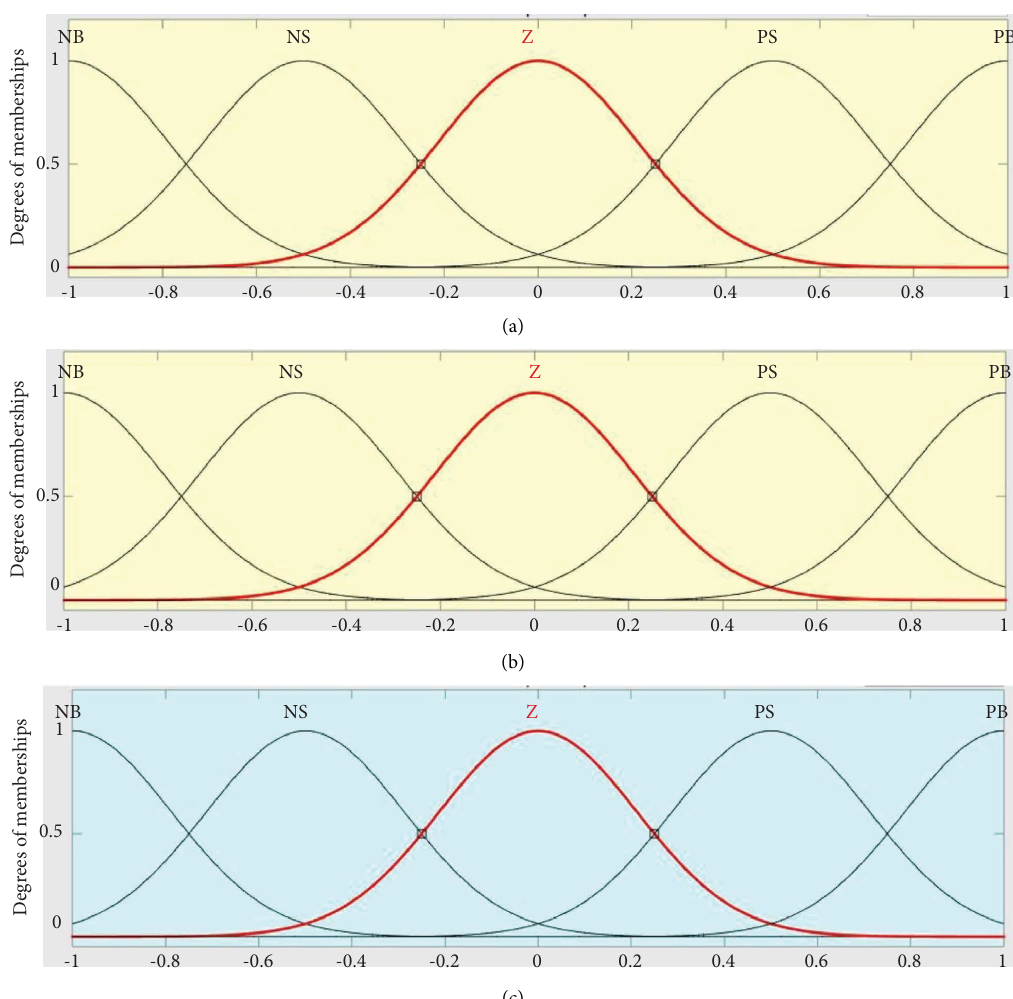
Figure 3: Gaussian membership function with two inputs and one output: (a) error, (b) change of error, and (c)